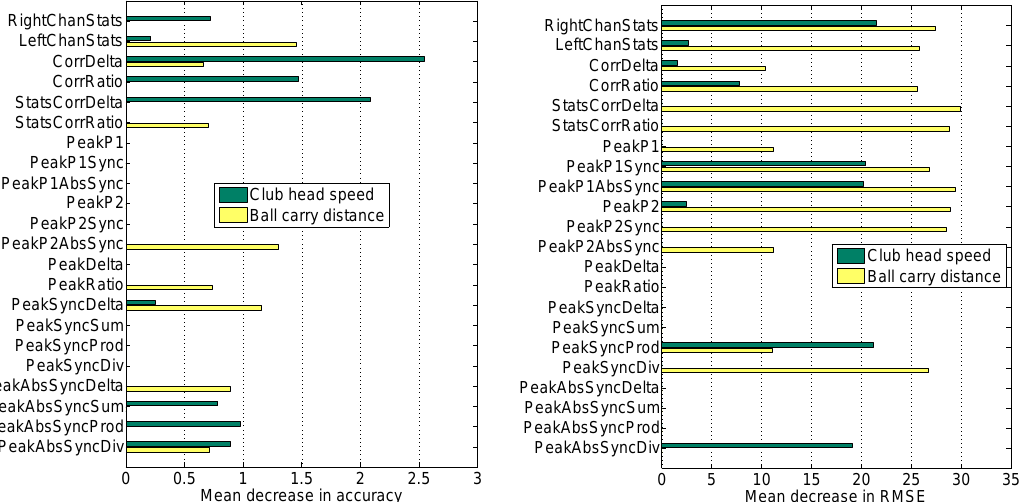
Figure 9. RF permutation-based variable importance in decision-level fusion for detection ( Left ) and regression ( Right )